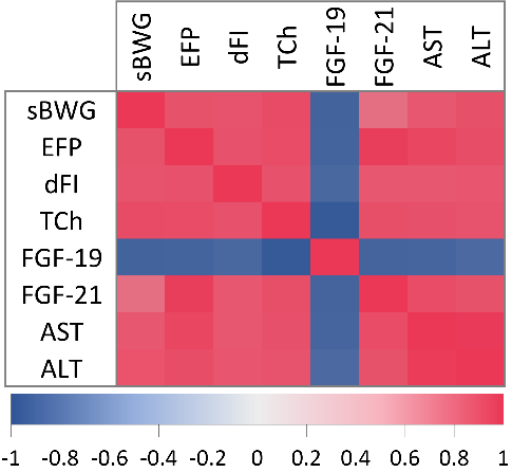
Figure 2. Pearson’s or Spearman’s correlation coefficients between physiological and metabolic pa-